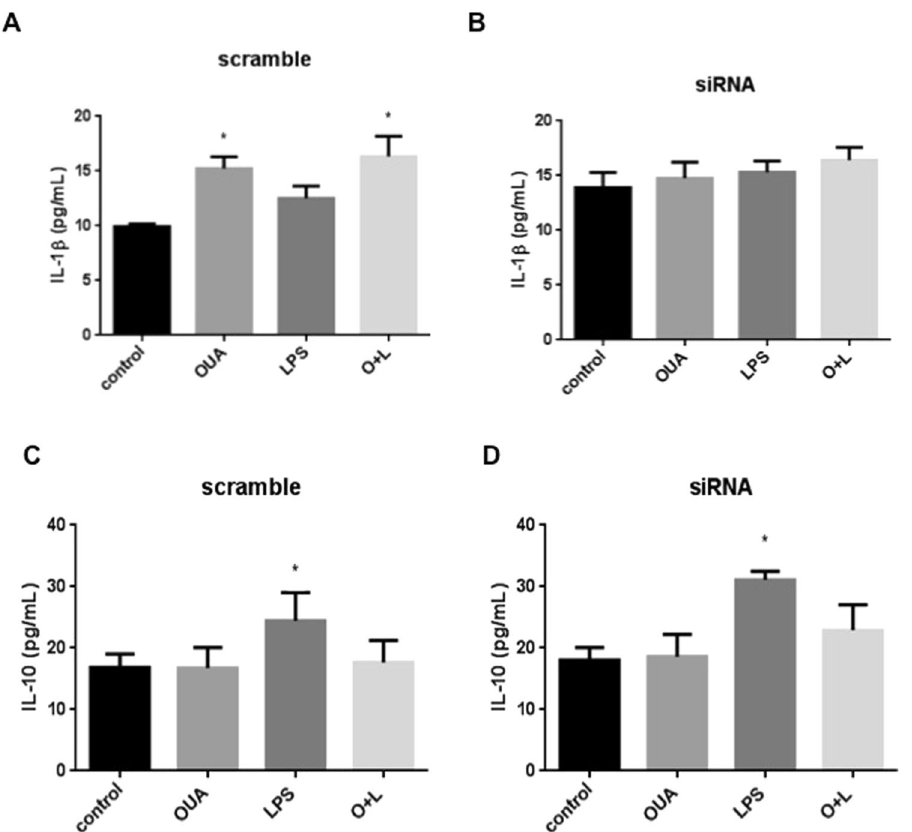
Figure 7. α 2-Na + ,K + -ATPase is not related to changes in IL-10 levels. Cell culture supernatants of scrambled sequence and siRNA cells after treatment with LPS(1 µ g/mL) and OUA (10 µ M) were collected and used to measure IL-1 β and IL-10 levels by ELISA (n = 6). ( A ) The levels of IL-1 β in the scrambled group, * p < 0.05 vs control. ( B ) The levels of IL-1 β in the siRNA group showed no difference between the groups. ( C ) The levels of IL-10 in the scramble group, * p < 0.05 vs control, OUA and O + L. ( D ) The levels of IL-10 in the siRNA group, * p < 0.05 vs control, OUA and O +